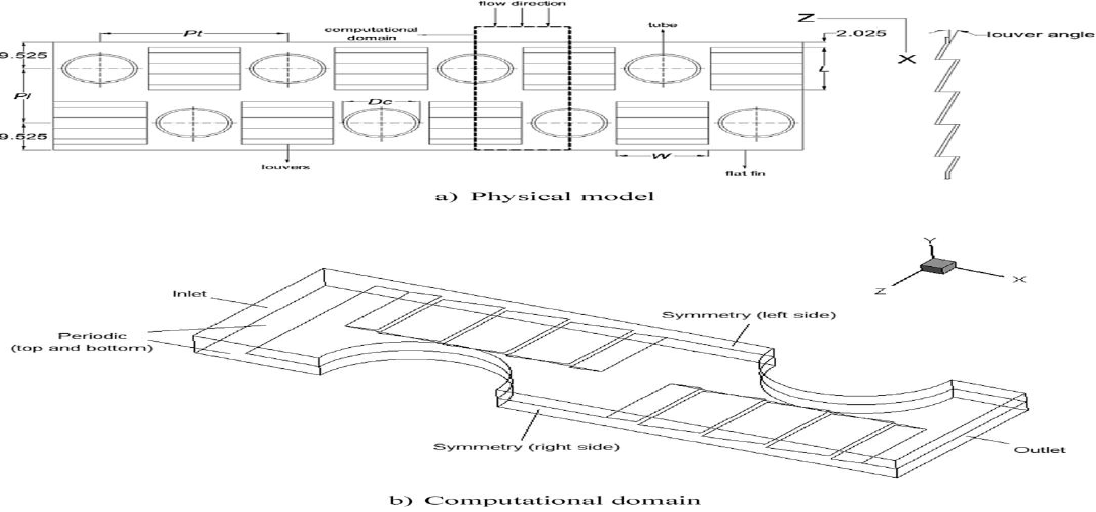
Figure 3: Physical model and computational domain [5].